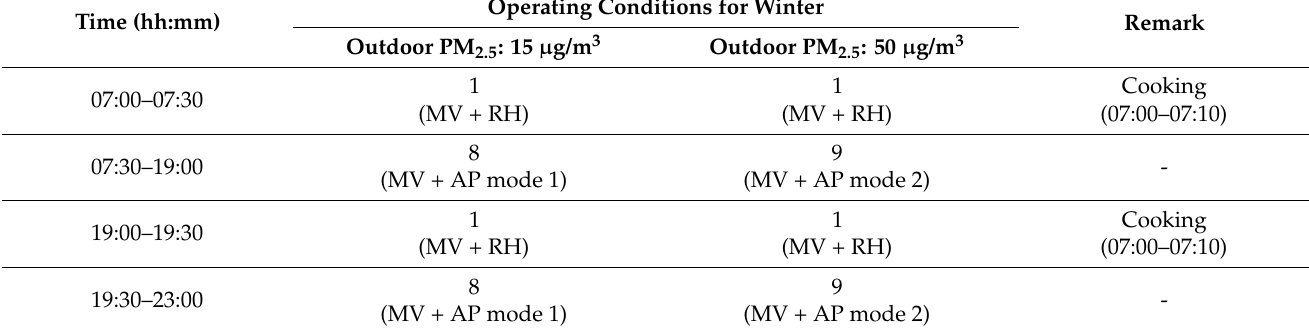
Table 6. Timetable of IAQ management operating conditions for the energy consumption reduction scenario in winter (NV: natural ventilation, MV: mechanical ventilation, RH: range hood, and AP: air